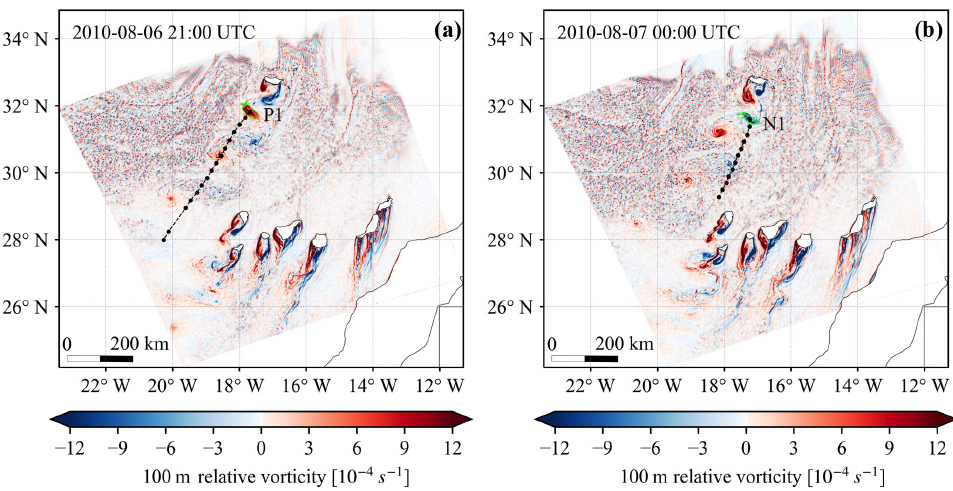
Figure 9. Relative vorticity at 100m and tracks of (a) a positive vortex P1 shed on 6 August 2010 at 21:00UTC and (b) a negative vortex N1 shed on 7 August 2010 at 00:00UTC. The relevant vortices are encompassed by lime contours, and the tracks in the next hours are shown with black lines and dots on an hourly basis. A gap in the lower half of the track of P1 results from a false rejection of that vortex by our algorithm. The geographic map is from Natural Earth.